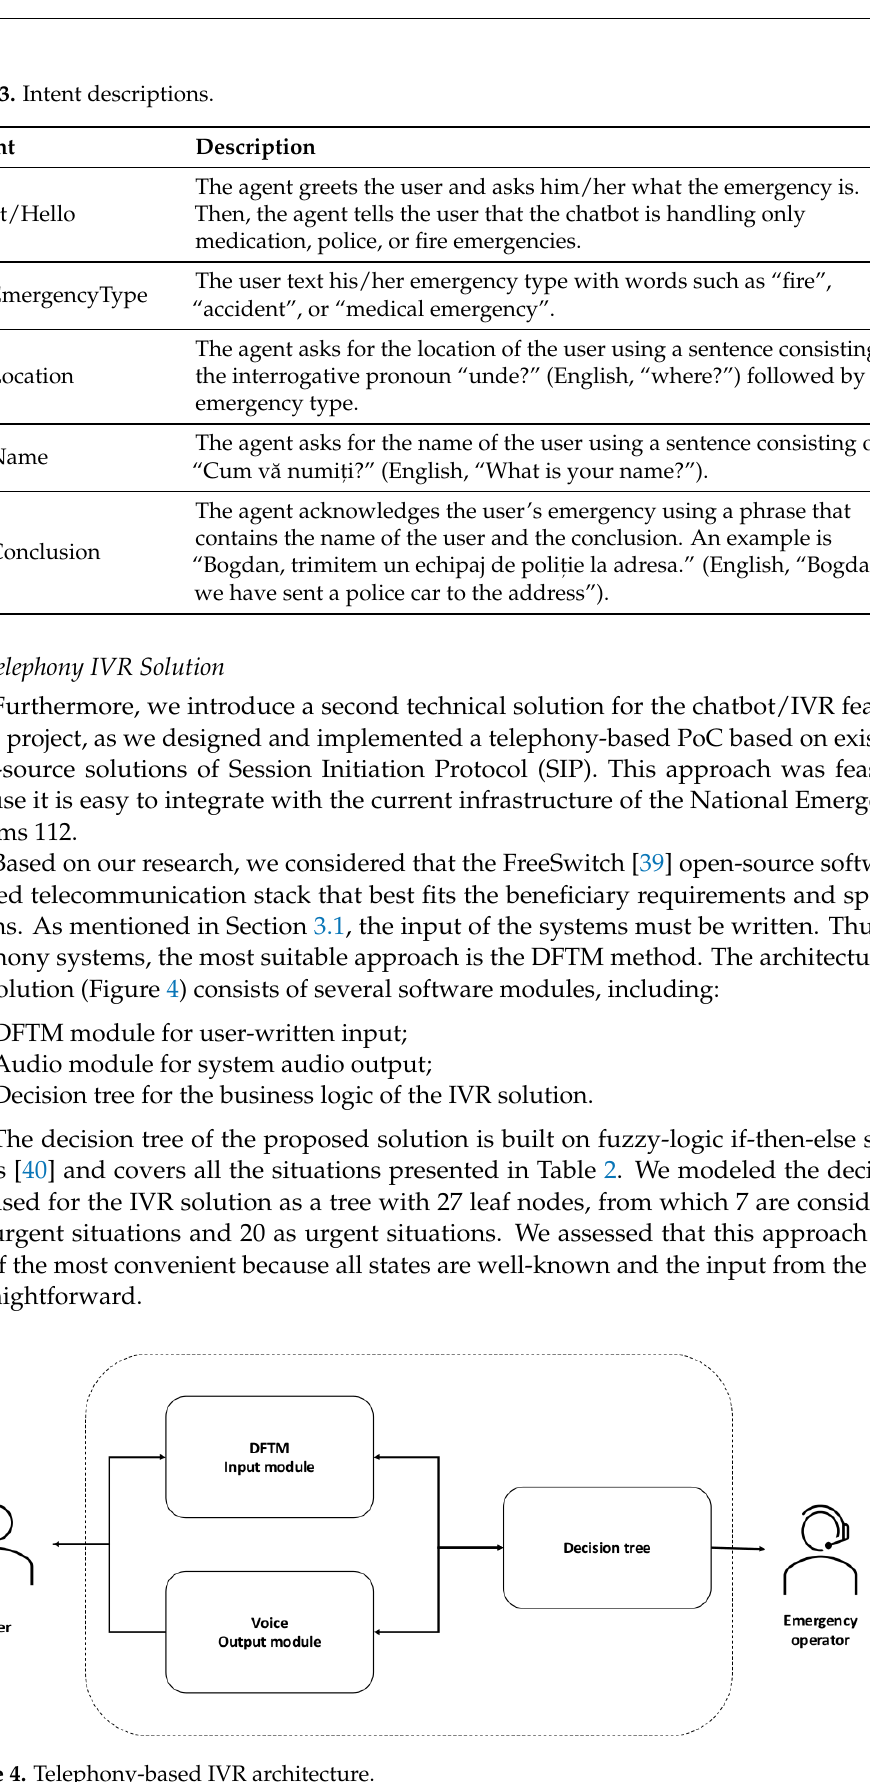
Figure 4. Telephony-based IVR